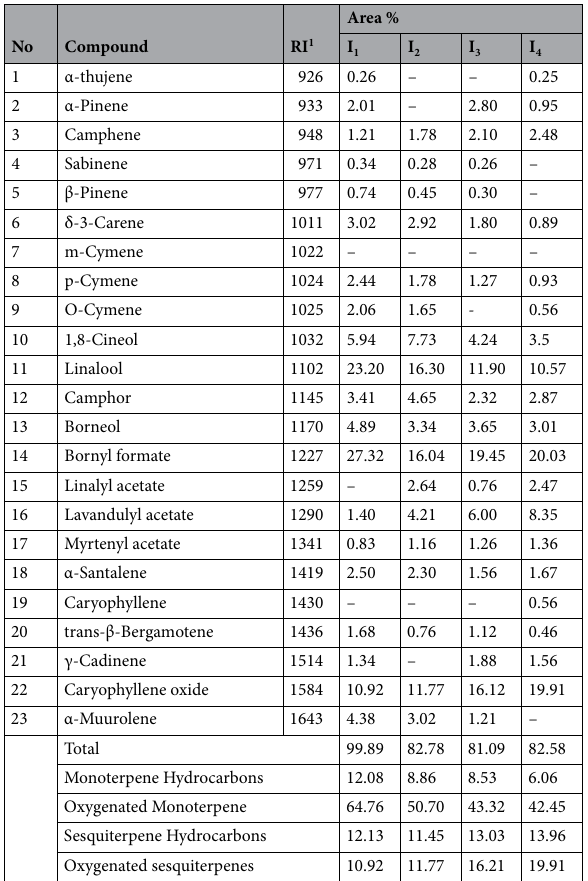
Table 4. Chemical composition of essential oils extracted from Lavandula angustifolia cv. Hidcote plants under different irrigation regime. 1. Retention Index, I 1 , 100–90% of field capacity (control)-Irrigation Regime 1; I 2 , 80–70% of field capacity-Irrigation Regime 2; I 3 , 60–50% of field capacity-Irrigation Regime 3; I 4 , 30–40% of field capacity-Irrigation Regime